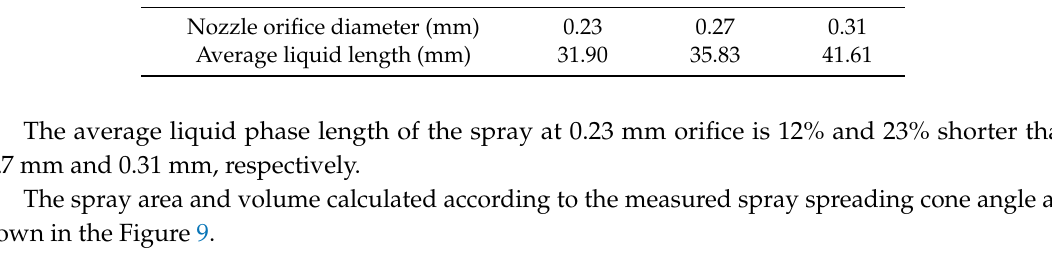
Table 5. The average liquid length of the spray.